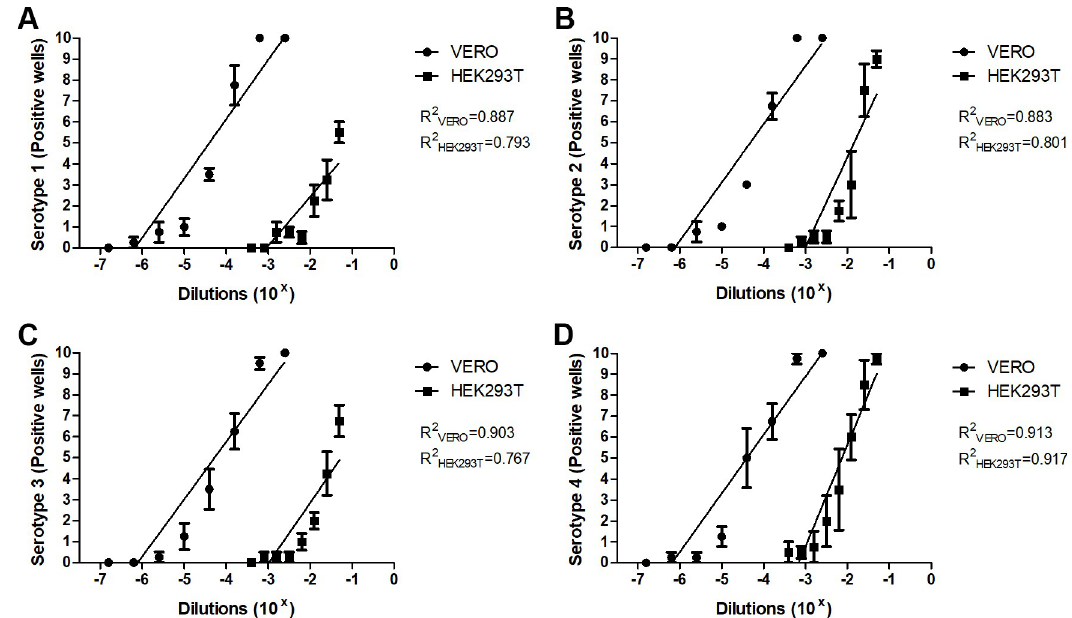
Fig 3. Dose-response curve showing VERO and HEK293T cells response after 7 days of infection with Dengvaxia. VERO (black circles) and HEK293T (black squares) cells infected with dengue vaccine (4,5–6,0 log 10 CCID 50 /dose) in dilutions of 10 − 2.6 –10 − 6.8 , 1:4 dilution factor, and 10 − 1.3 –10 − 3.4 , 1:2 dilution factor, respectively, and analyzed by immunocolorimetric assay after 7 days of incubation. Infection of serotype 1 (A), serotype 2 (B), serotype 3 (C) and serotype 4 (D) evaluated by the presence of staining after incubation with serotype-specific mAb—positive wells. Linear regression (straight lines) of infectious responses in VERO and HEK293T cells for serotypes 1 (R 2 VERO = 0.887 and R 2 HEK293T = 0.793), serotype 2 (R 2 VERO = 0.883 and R 2 HEK293T = 0.801), serotype 3 (R 2 VERO = 0.903 and R 2 HEK293T = 0.767) and serotype 4 (R 2 VERO = 0.913 and R 2 HEK293T = 0.917). Data presented as mean ± SEM. n = 4. to different DENV vaccine dilutions from 10 − 1.3 to 10 − 3.4 , following a dilution factor of 1:2, whereas VERO cells were subjected to dilutions from 10 − 2.6 to 10 − 6.8 , with a dilution factor of 1:4, during 7 days of incubation. In this set of experiments, specific monoclonal antibodies for each serotype determined separately the degree of infectivity of the DENV vaccine both in VERO and HEK293T cells. We observed infection of HEK293T cells only at the most concen- trated dilutions of the vaccine, as determined by the presence of dark color after incubation with monoclonal antibody specific to each dengue serotype (positive wells). Even though, the DENV vaccine dilutions used to infect VERO cells were less concentrated when compared to the ones used to infect HEK293T cells, VERO cells confirmed their higher susceptibility to the infection with this vaccine under our experimental conditions. The dose-response curves and the linear coefficient of the regression equation of infectious responses in VERO and HEK293T cells for each serotype are shown in Fig 3 (serotype 1 R 2 = VERO 0.887 and R 2 = 0.793, Fig 3A; serotype 2 R 2 = 0.883 and R 2 = 0.801, Fig 3B; HEK293T VERO HEK293T serotype 3 R 2 = 0.903 and R 2 = 0.767, Fig 3C and serotype 4 R 2 = 0.913 and VERO HEK293T VERO